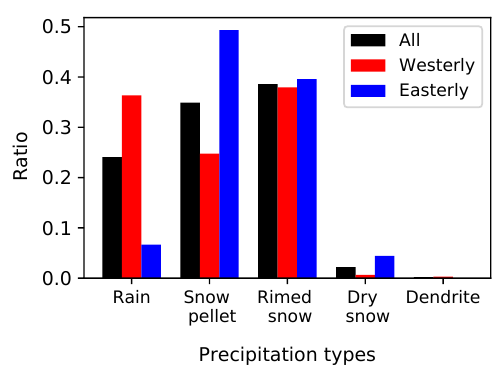
Figure 8. The fraction (%) of precipitation and crystal types di- agnosed with the Ishizaka et al. (2013) method using optical dis- drometer information over the March–April 2015 period. A sum- mary is provided for all events, westerly flow events and easterly flow